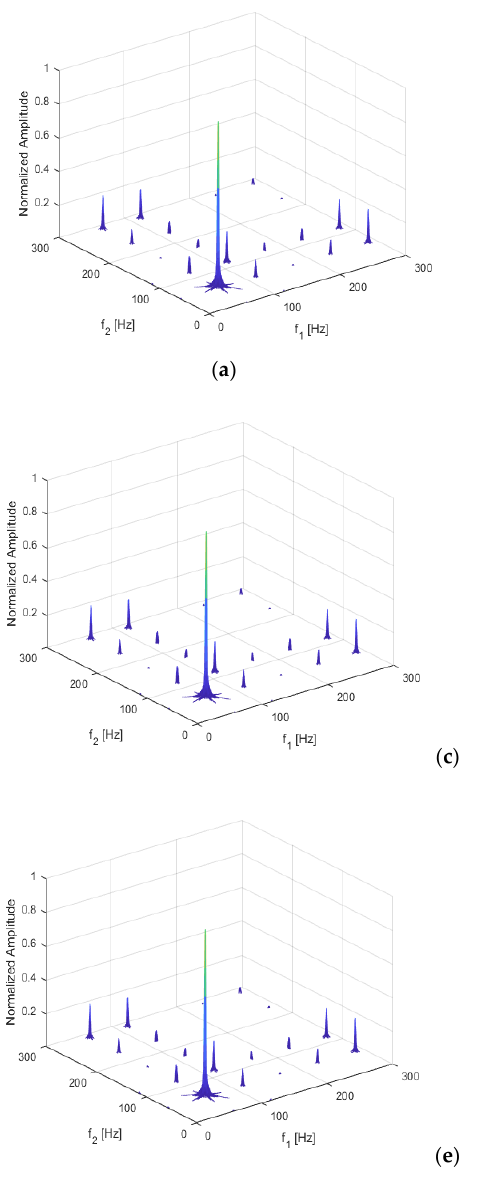
Figure 12. Bispectrum when ( a ) the signal is noiseless; ( b ) SNR = 90 dB; ( c ) SNR = 70 dB; ( d ) SNR = 50 dB; ( e ) SNR = 30 dB; ( f ) SNR = 10 dB.